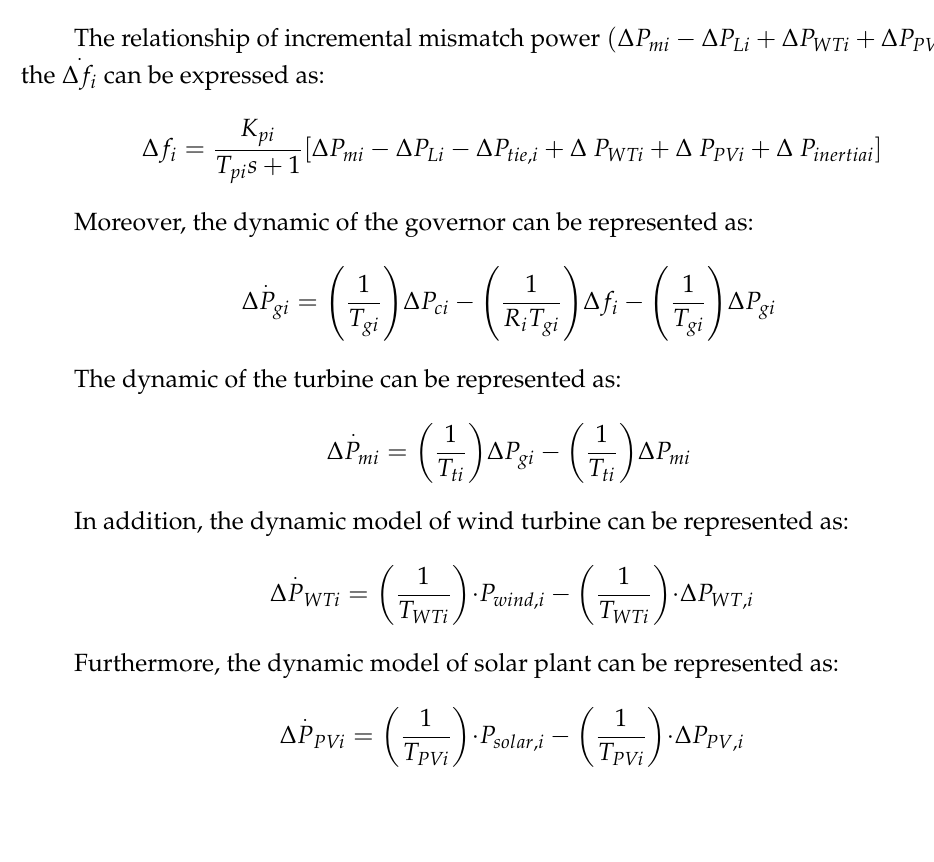
Figure 1. A schematic representation of the system under consideration.